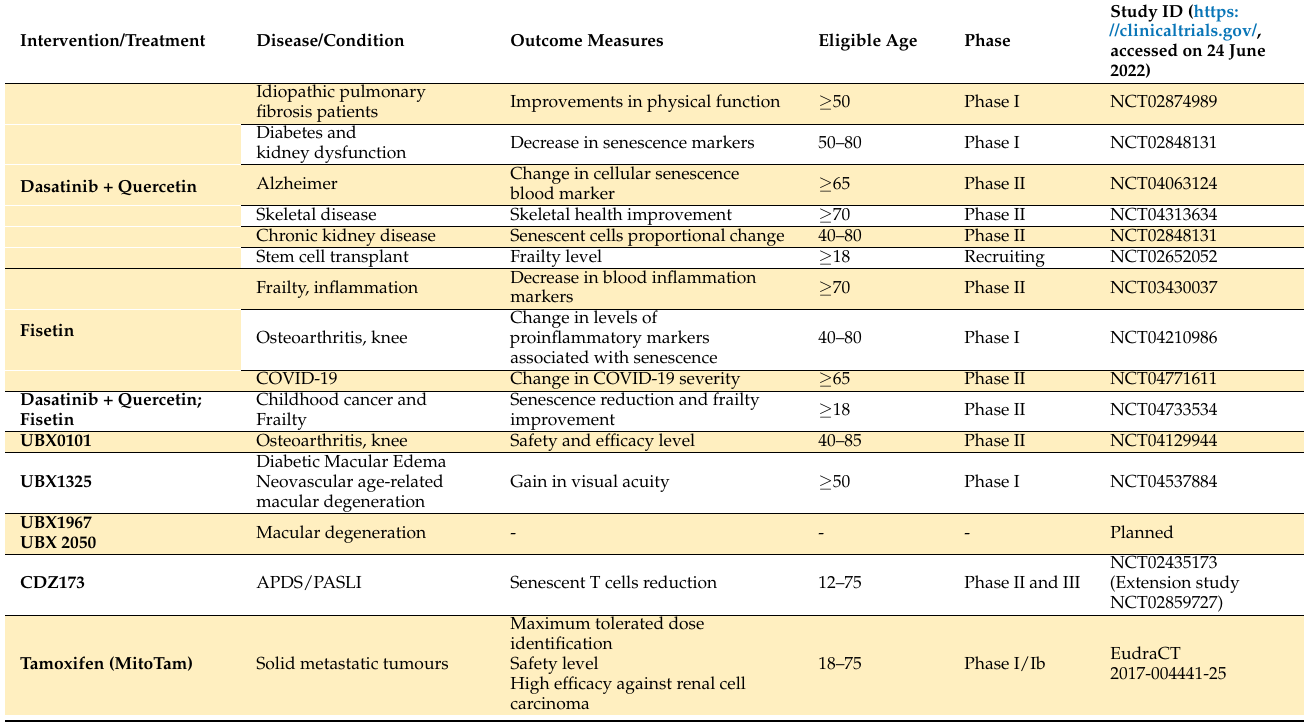
Table 1. Ongoing and planned clinical trials using senolytic drug